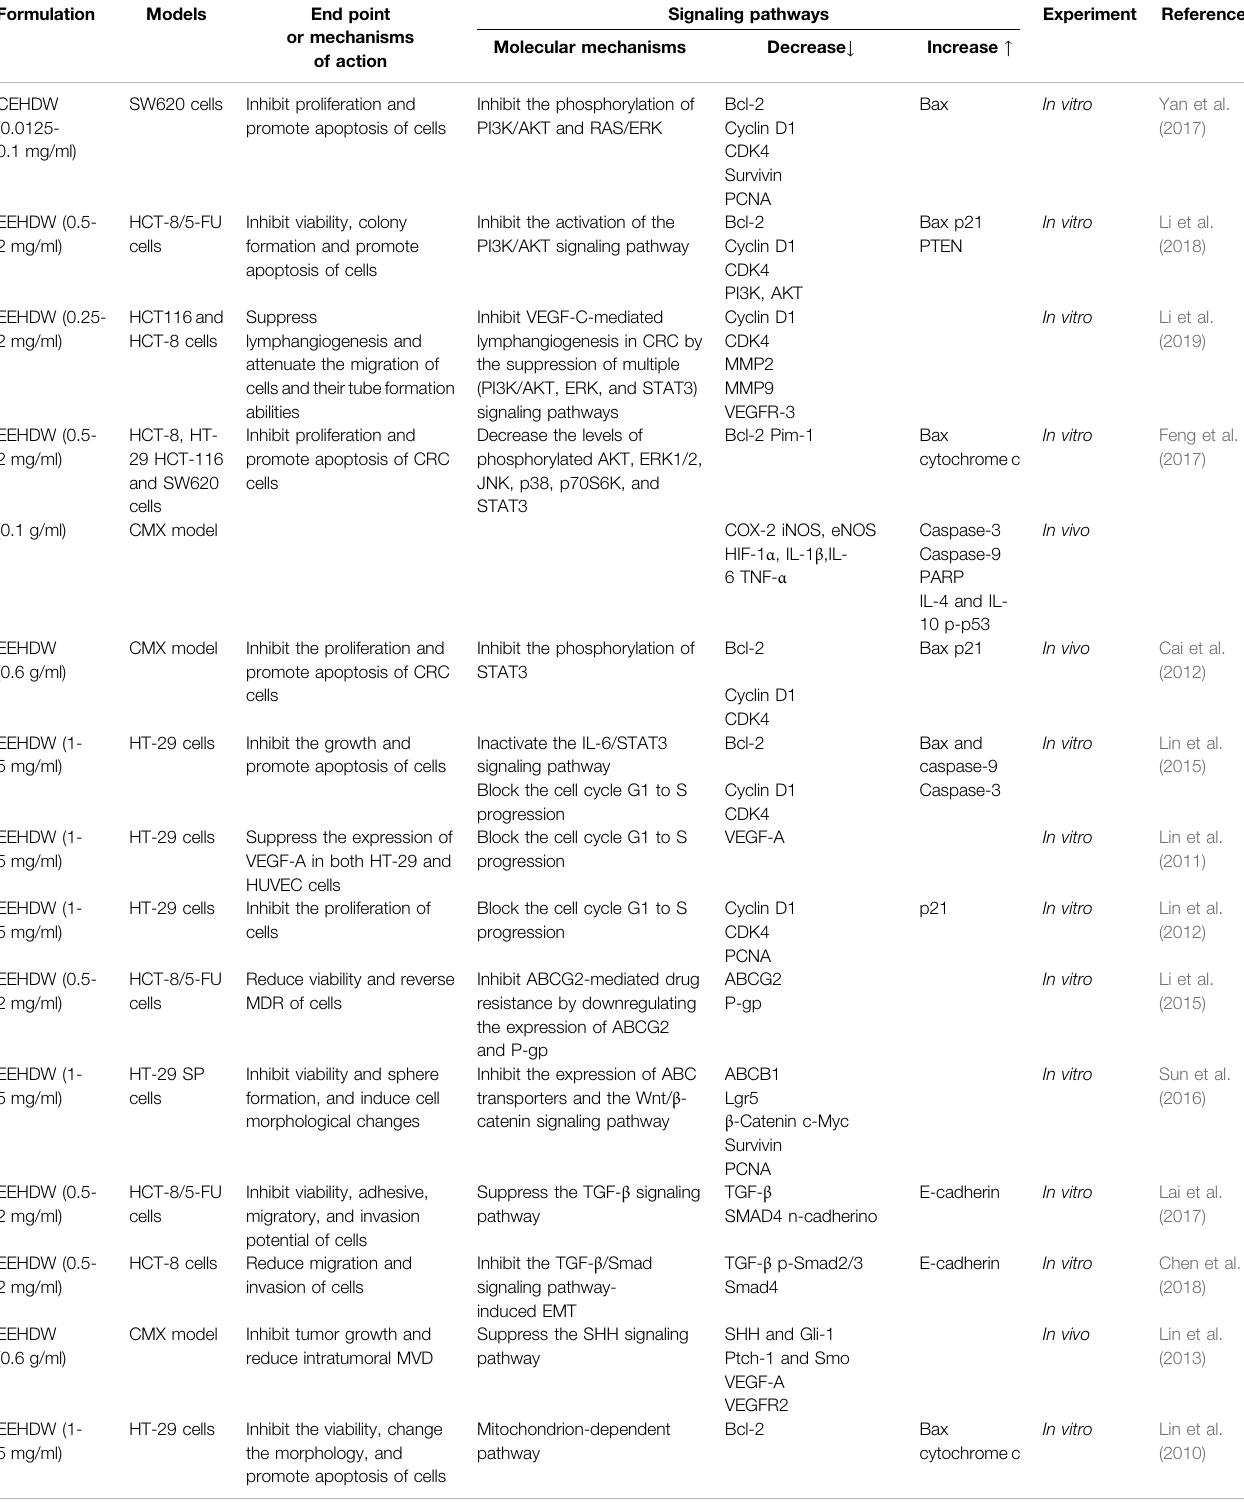
TABLE 1 | Potential signaling pathways of HDW extracts against CRC.